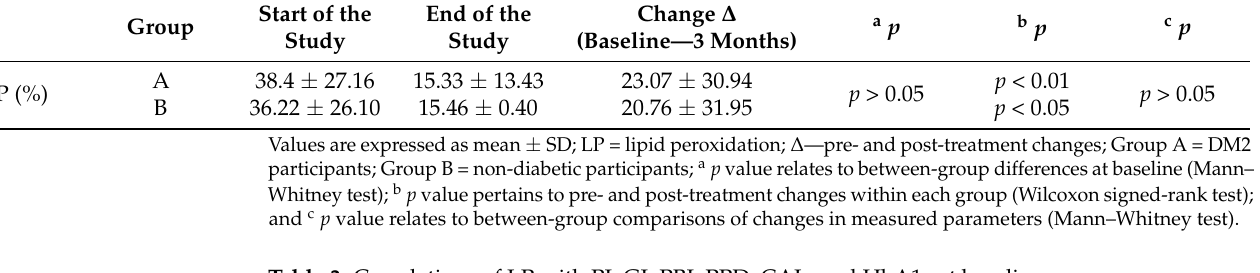
Table 3. Correlations of LP with PI, GI, PBI, PPD, CAL, and HbA1c at baseline.